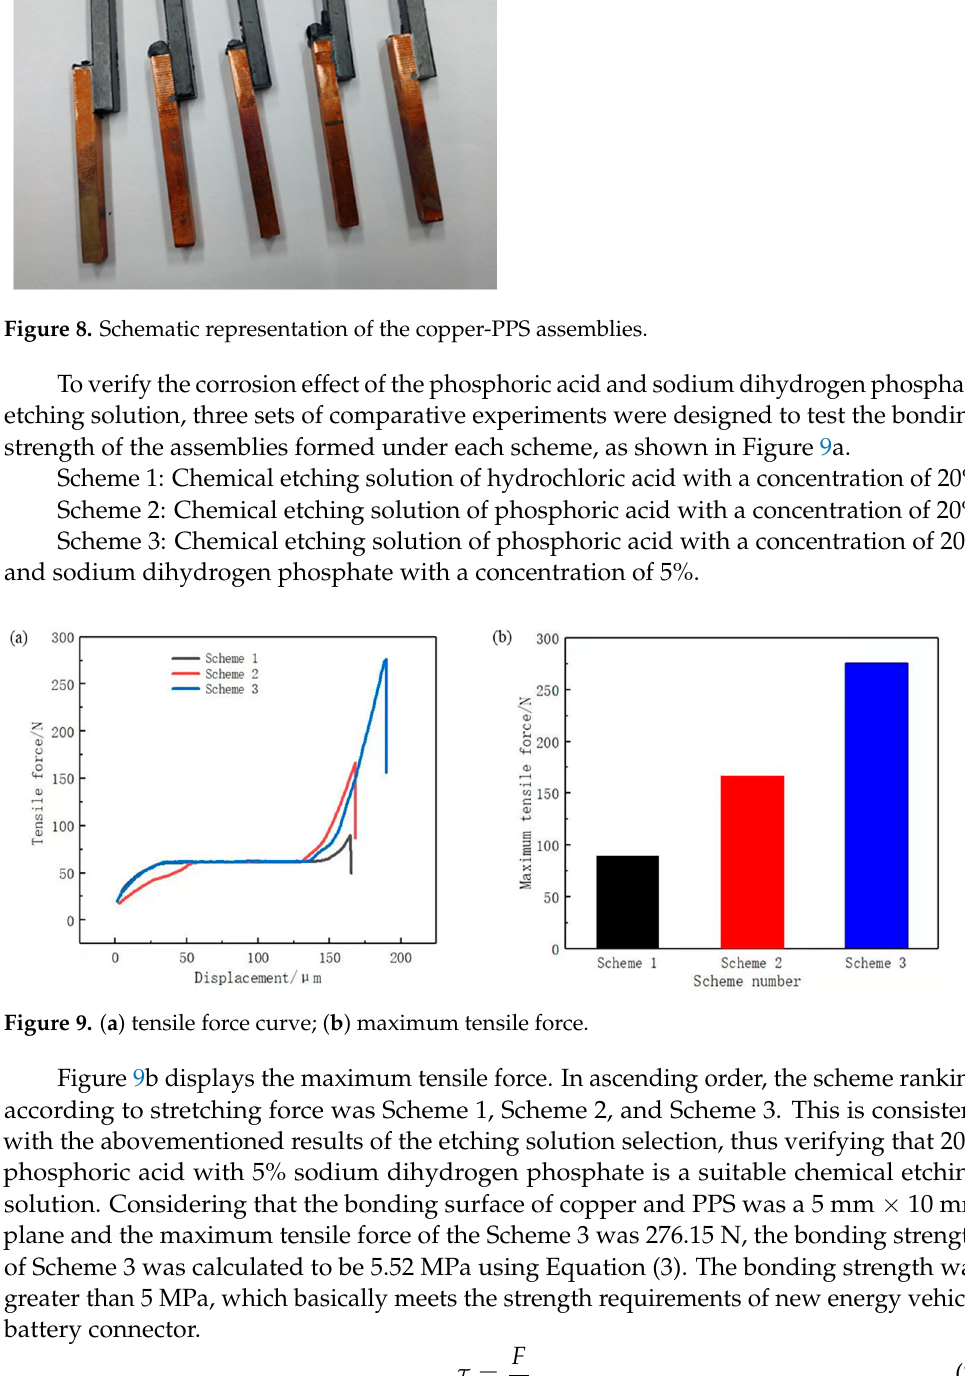
10 of 15 Table 6. Parameters of the injection molding machine. Screw Di- ameter/mm Metering Zone Length/mm